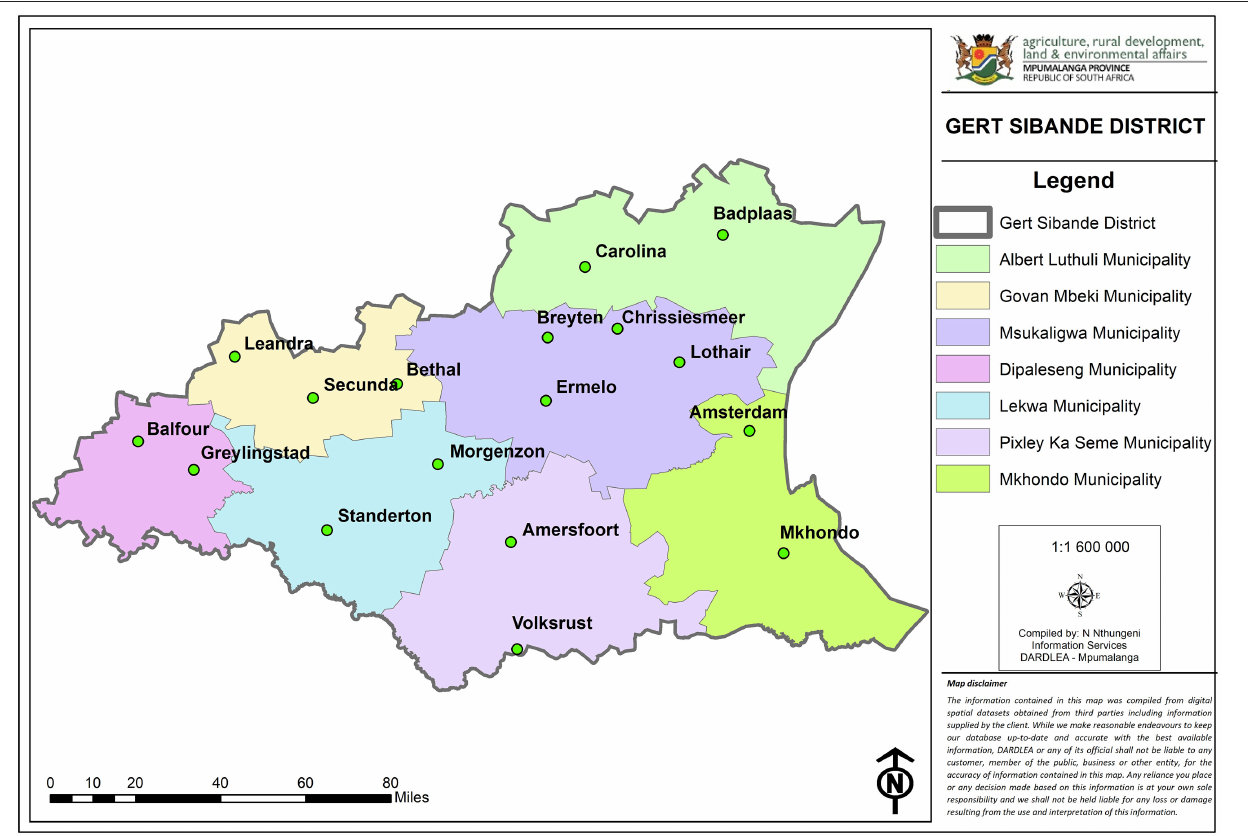
FIGURE 1 | Map of Gert Sibande District.